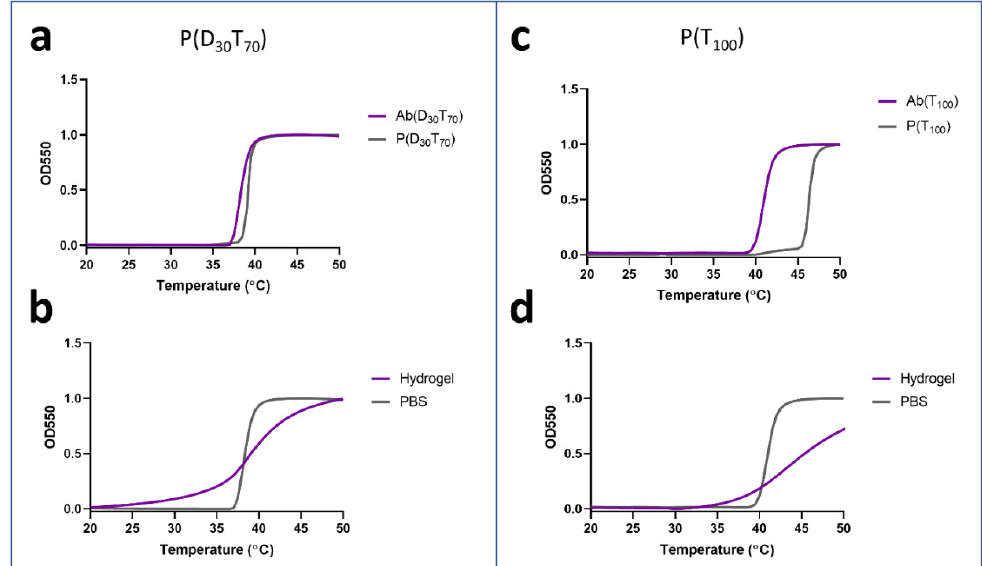
Figure 4. Temperature-sensitive turbidity curves of P(D x T y ) copolymers (5 mg mL − 1 ), Ab(D x T y ) (0.5 mg/mL − 1 ) in PBS and Ab(D x T y ) within the pCB hydrogel. ( a ) The copolymer P(D 30 T 70 ) showed similar temperature responses as a free polymer and a conjugate, Ab(D 30 T 70 ). ( b ) Compared the PBS, the phase transition profile of Ab(D 30 T 70 ) was broadened when encapsulated within the pCB hydrogel. ( c ) The Ab(T 100 ) conjugate phase transitioned at lower temperatures than the corresponding free polymer, P(T 100 ). ( d ) Compared the PBS, the phase transition profile of Ab(T 100 ) was broadened when encapsulated within the pCB hydrogel.